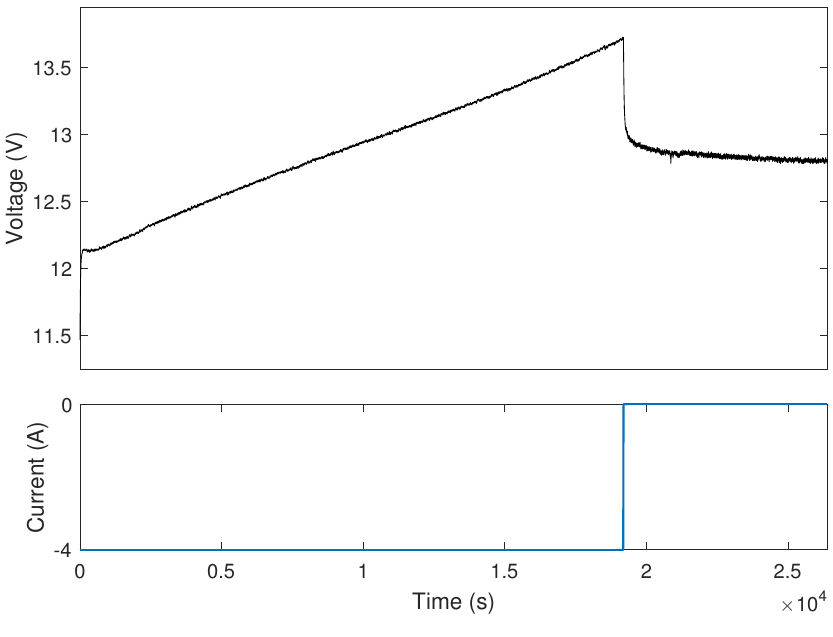
Figure 5. Battery charge response in test 5 ( I = I c 2 = − 4